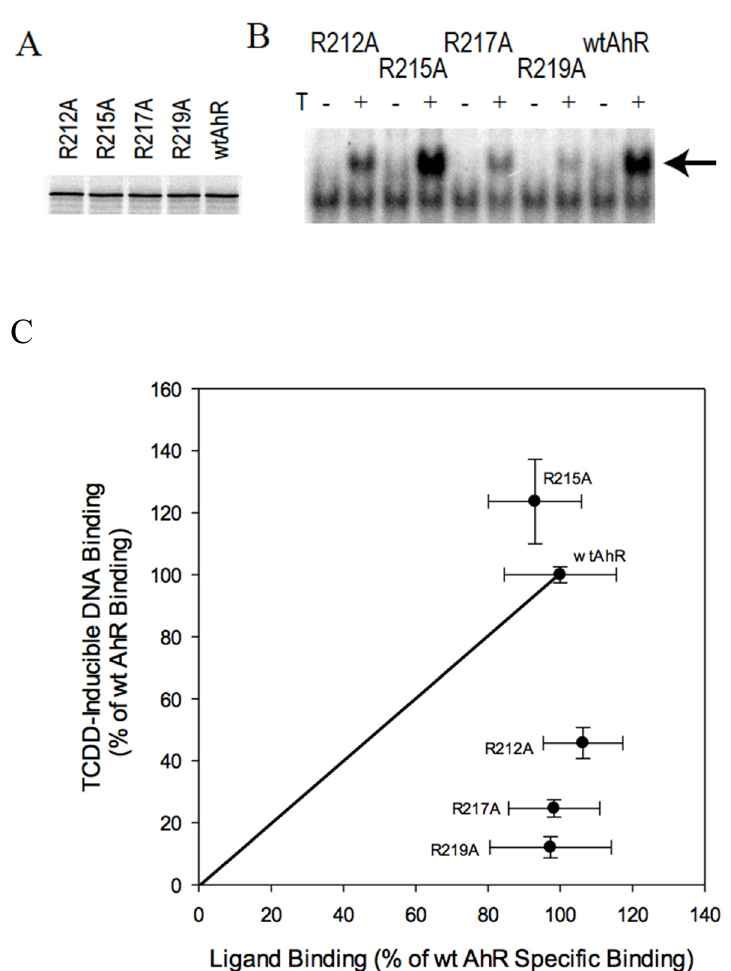
Figure 4. E ff ects of mutagenesis of select amino acids within the Arg-Cys-rich region on TCDD-inducible Figure 4. Effects of mutagenesis of select amino acids within the Arg-Cys-rich region on AhR transformation / DNA binding and [ 3 H]TCDD specific binding. ( A , B ). In vitro analysis of the wild TCDD-inducible AhR transformation/DNA binding and [ 3 H]TCDD specific binding. ( A , B ). In vitro type (wt) and mutant AhRs was as described in the legend to Figure 2. ( C ) Comparison of ligand analysis of the wild type (wt) and mutant AhRs was as described in the legend to Figure 2. ( C ) binding and ligand-dependent DNA binding for wt and mutant AhRs was as described in the legend Comparison of ligand binding and ligand-dependent DNA binding for wt and mutant AhRs was as for Figure 2C. Values are presented as the mean ± standard deviation of triplicate independent reactions, described in the legend for Figure 2C. Values are presented as the mean ± standard deviation of and the results presented are representative of at least three independent triplicate independent reactions, and the results presented are representative of at least three independent experiments.